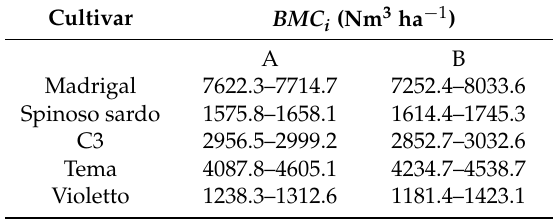
Table 4. Biomethane yield ranges per ha (BMC i ) (A = wet basis; B = wet basis with catalytic enzymes).